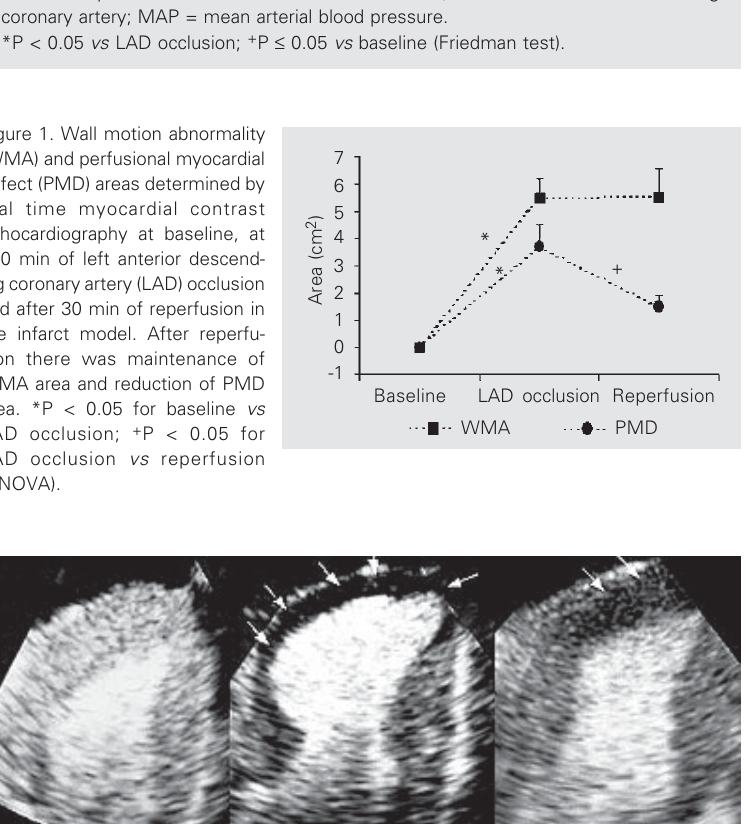
Figure 2. Representative example of real time myocardial contrast echocardiography in the infarct model showing normal myocardial perfusion at baseline (left) and the risk area during left anterior descending coronary artery occlusion (arrows) in the center. After 30 min of coronary reperfusion there was a clear reduction of perfusional defect size (arrows) and the infarcted area remained limited to the apical region (right).